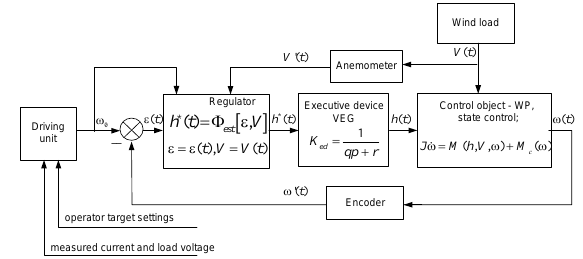
Figure 4 - Structural control scheme of the h- parameter for the mechanical stabilization of the angular speed of rotor